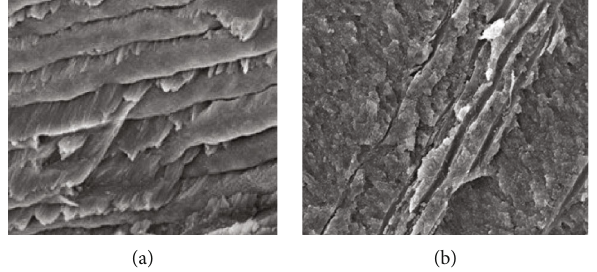
Figure 4: Ultrastructural evaluation. (a) A scanning electron microscopy (zoom × 2000) view showing the prismatic aspect of the enamel of the patient ’ s temporary tooth. (b) A scanning electron microscopy (zoom × 2000) view showing some dentinal tubules in longitudinal section.